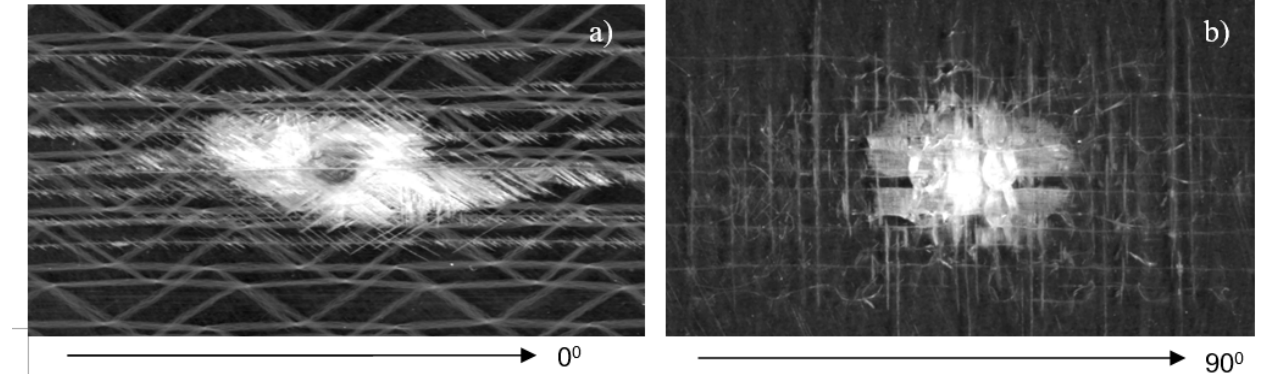
Figure 28. Impact-induced cracking predominantly along stiff the 0 ◦ and − 45 ◦ directions in 4-axial ( a ) and bi-axial ( b ) fabric